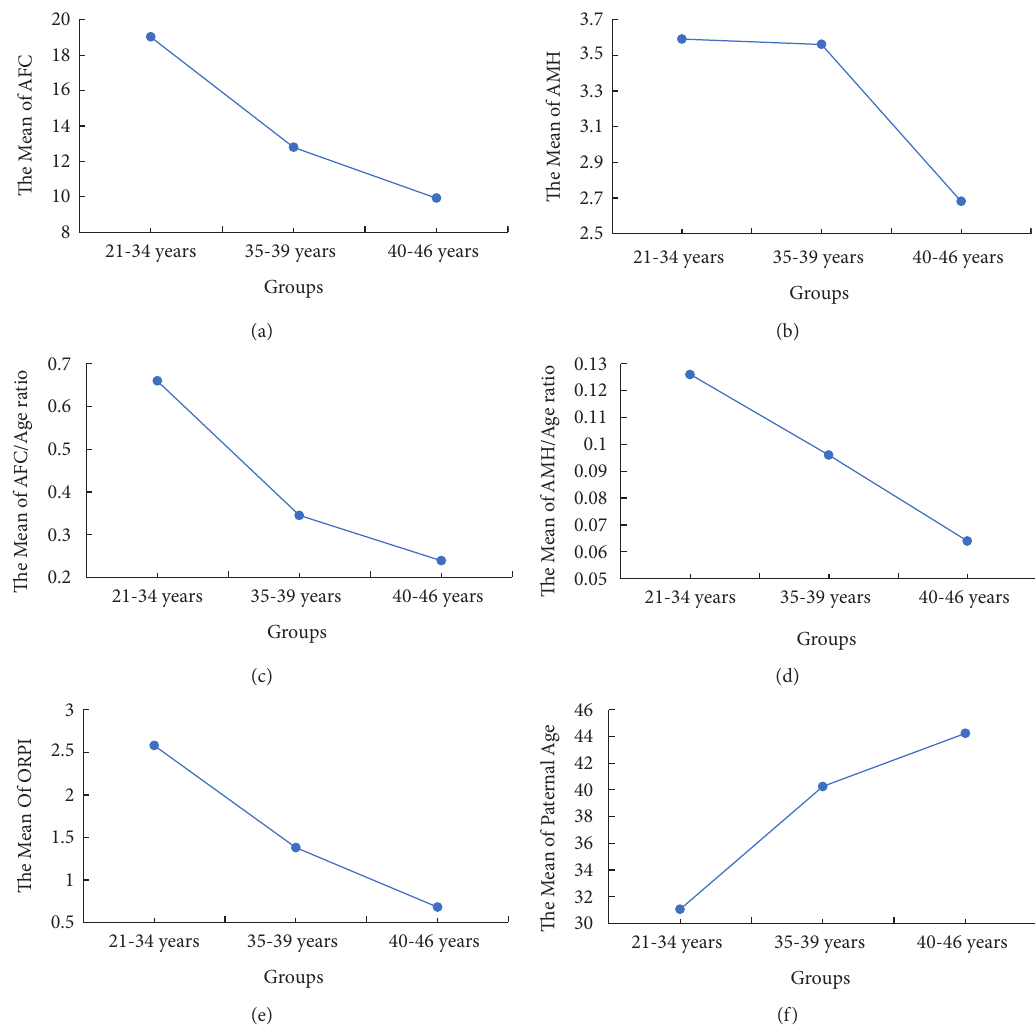
Figure 1: Mean plots of variables presenting the increasing/decreasing pattern of median values with respect to increasing age of subjects. (a) The decreasing pattern of AFC; (b) the decreasing pattern of AMH; (c) the decreasing pattern of AFC/age ratio; (d) the decreasing pattern of AMH/age ratio; (e) the decreasing pattern of ORPI; (f) the increasing pattern of paternal age. AFC, antral follicle count; AMH, anti- M¨ullerian hormone; ORPI, ovarian response prediction